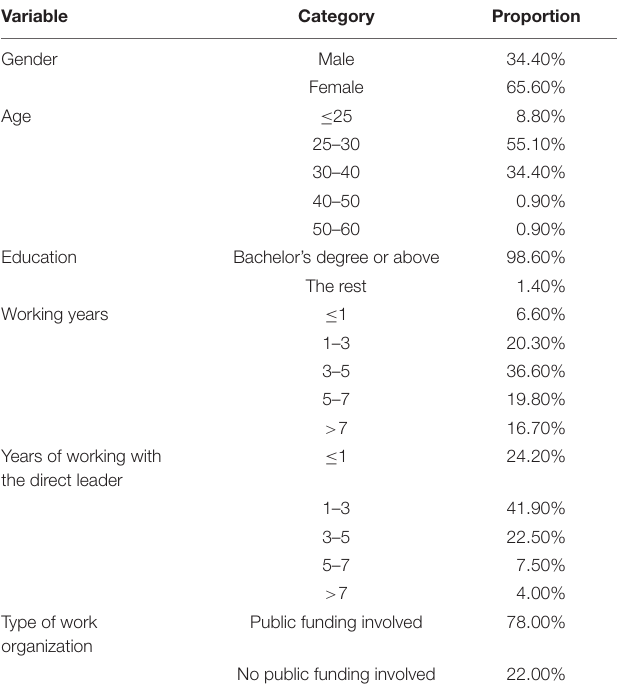
TABLE 1 | Sample distribution